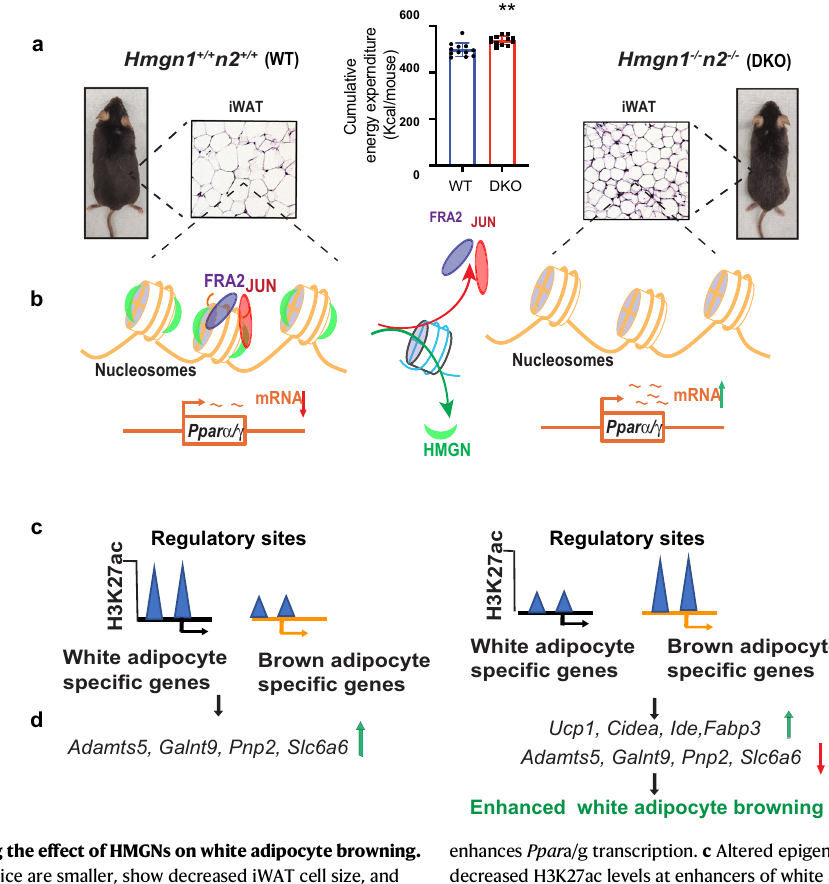
Fig. 7 | Modelsummarizing theeffect ofHMGNsonwhiteadipocytebrowning. a Mouse phenotype DKO mice are smaller, show decreased iWAT cell size, and elevated energy expenditure. Data are the mean±SD; n =3 for each group. * p <0.05. b Altered binding of transcription regulators. Loss of HMGN